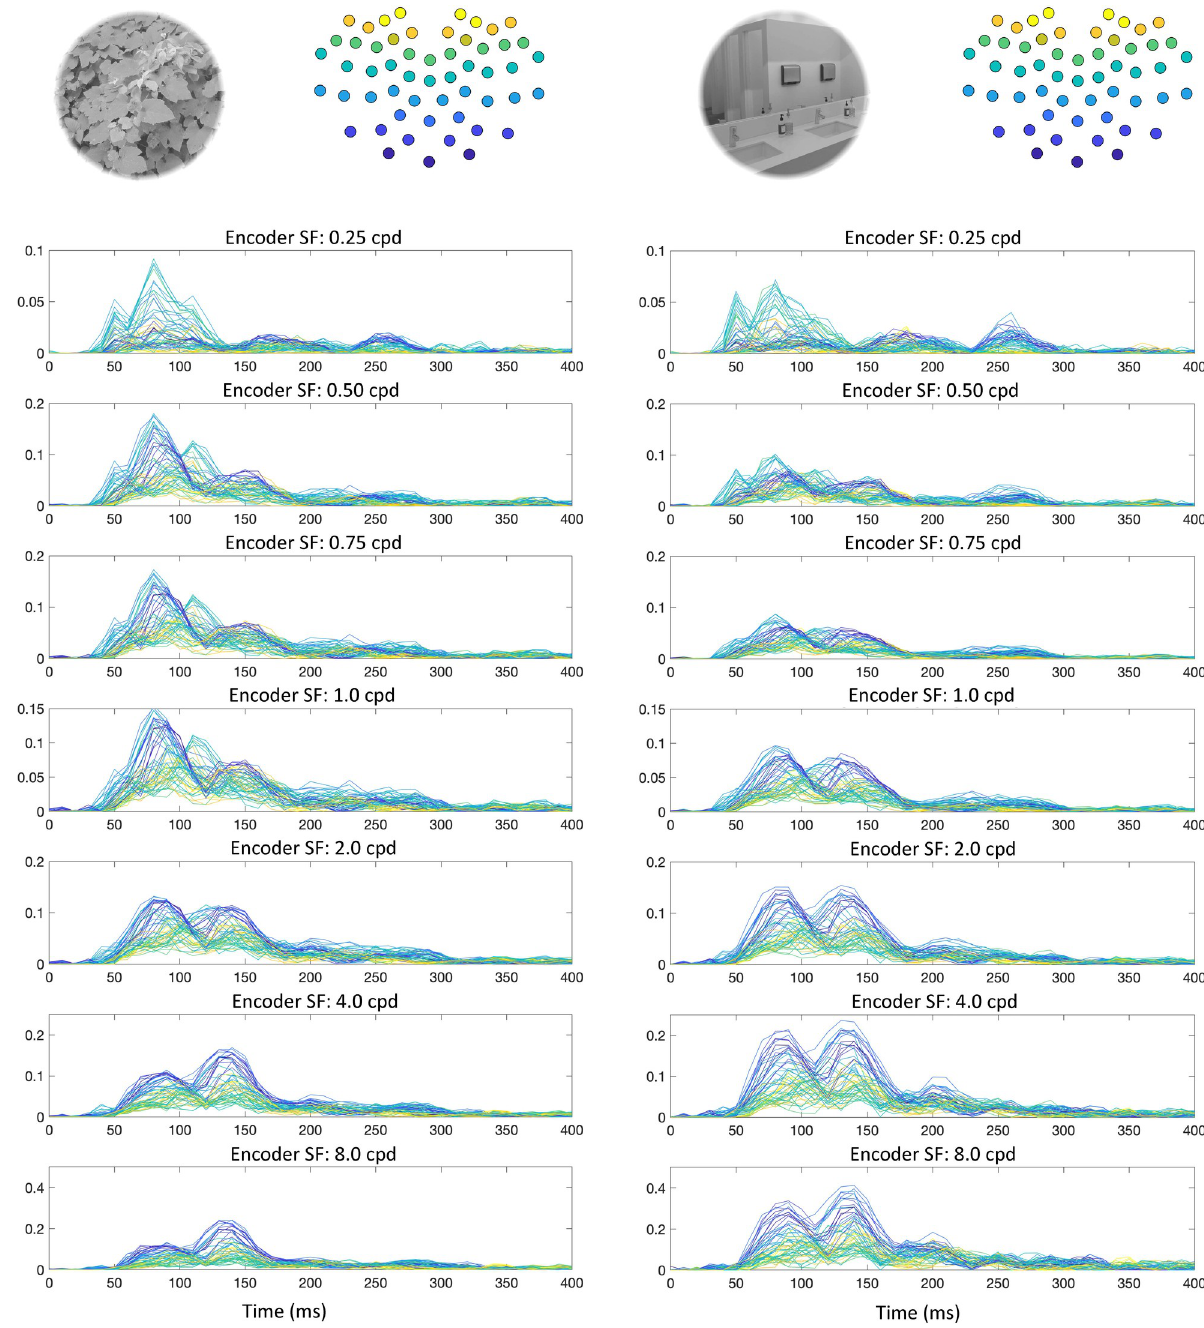
Fig 10. Encoder probability over time for two stimulus examples (upper left of each set of plots), averaged across participants. The y-axes show participant-averaged encoder probability, with time (ms) on the x-axes. Each trace is from a specific electrode and color-coded from ventral-posterior to dorsal posterior electrode (illustrated at the upper right of each set of